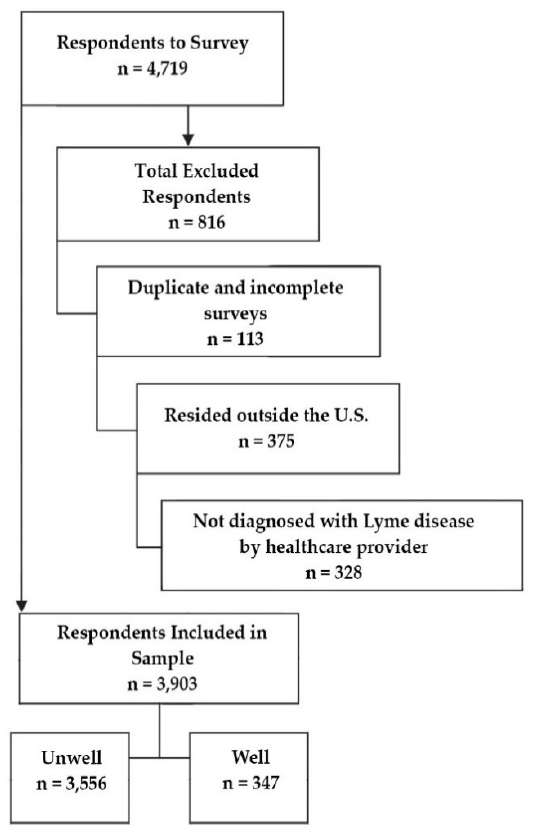
Figure 1. Preliminary sample, exclusions, and final sample size determination.